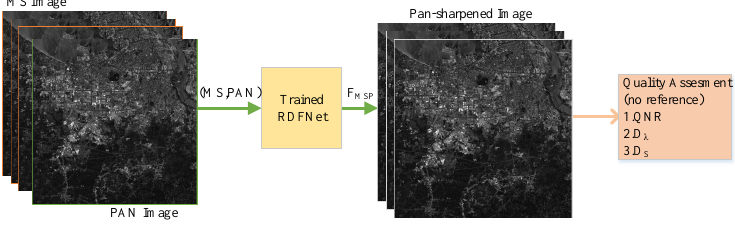
Figure 6. Testing and evaluating RDFNet with MS and PAN images with full